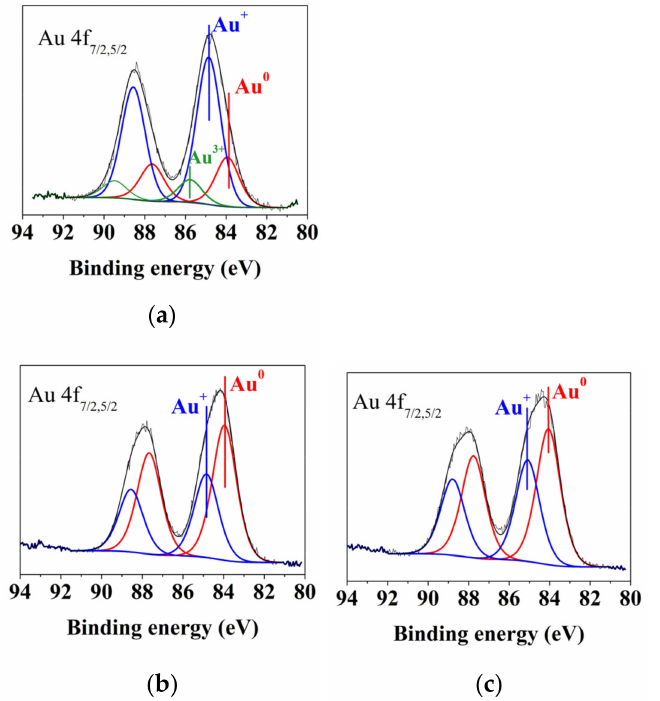
Figure 9. Au 4f spectra of CoFe 2 O 4 /Au nanoparticles synthesized under the conditions in Figure 3: